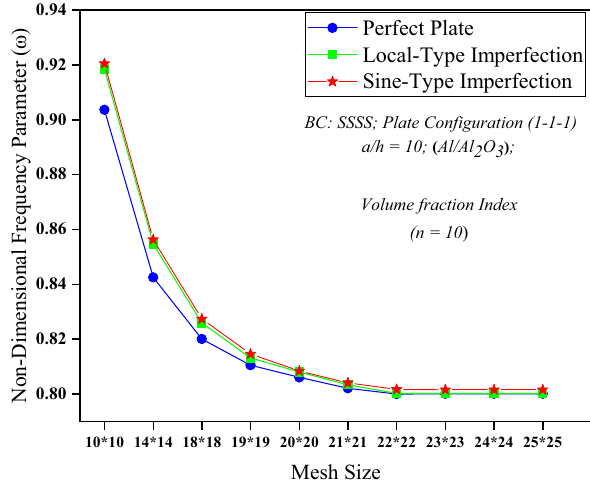
Figure 5: Convergence results of SFGM plate with imperfection models by varying mesh sizes at ( n = 10 ) using Al/Al 2 O 3 .